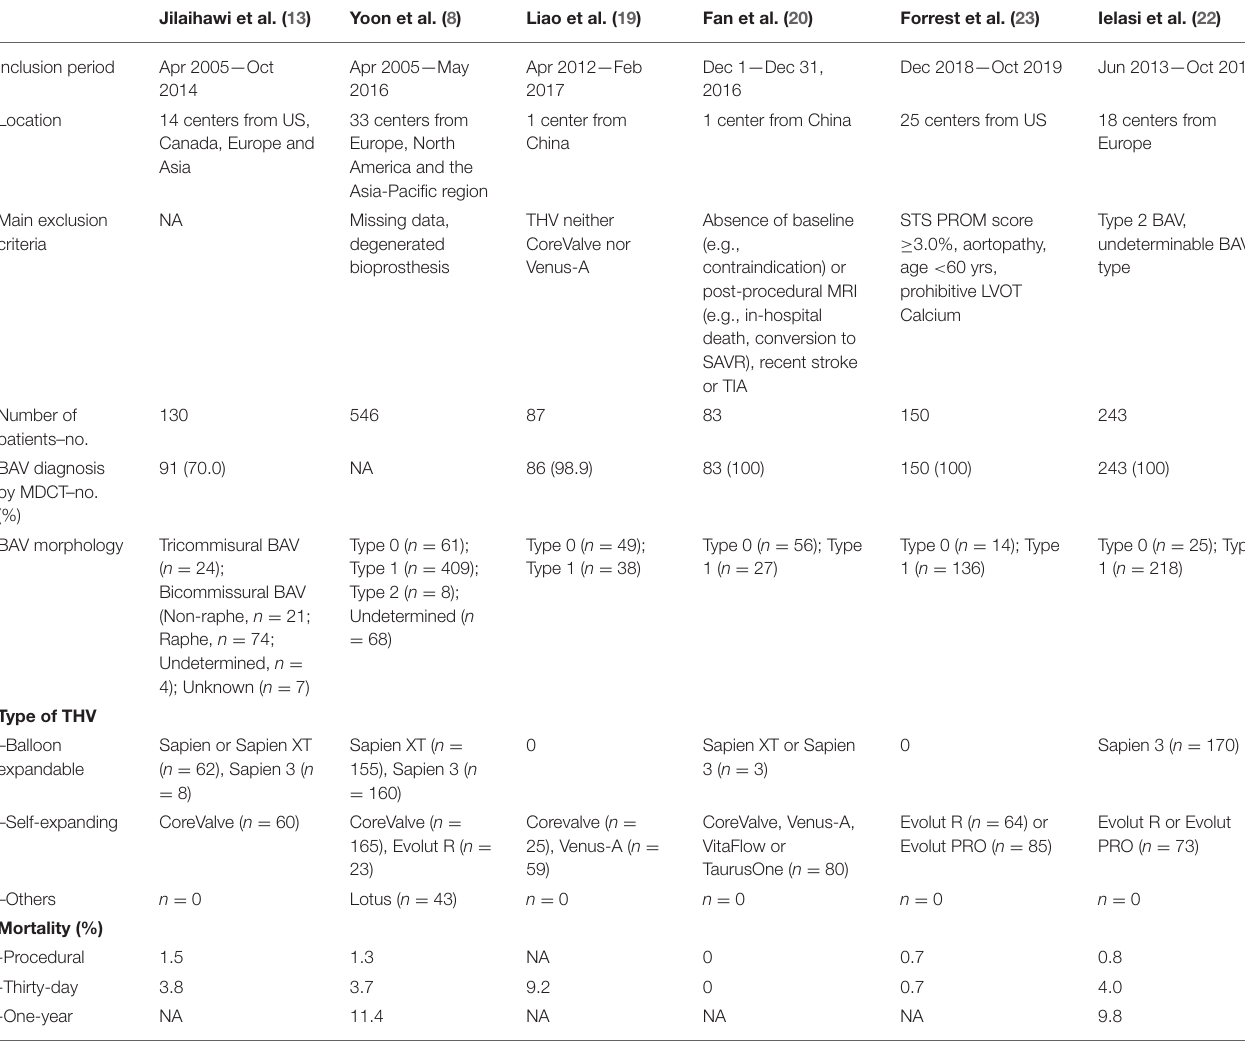
TABLE 2 | Overview of included BAV